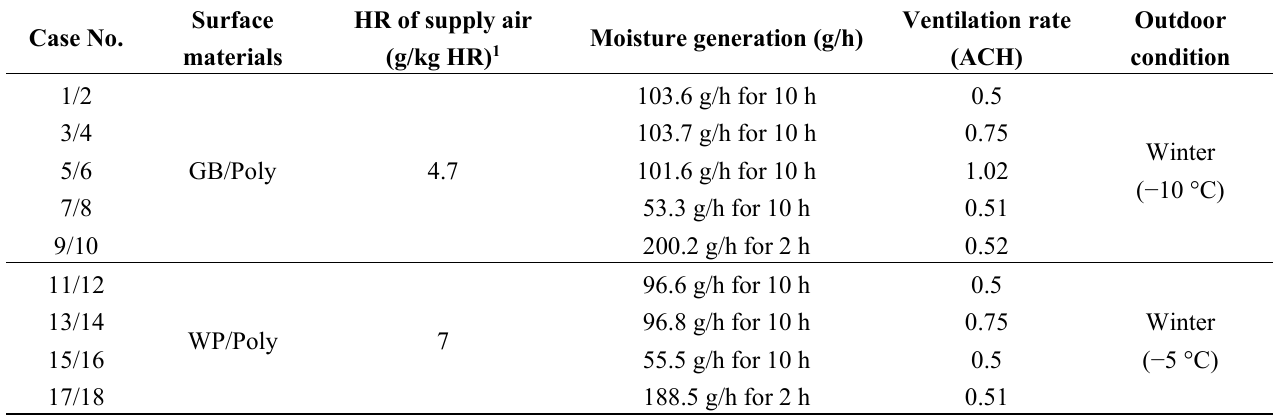
Table 1. Cases analyzed by simulations using